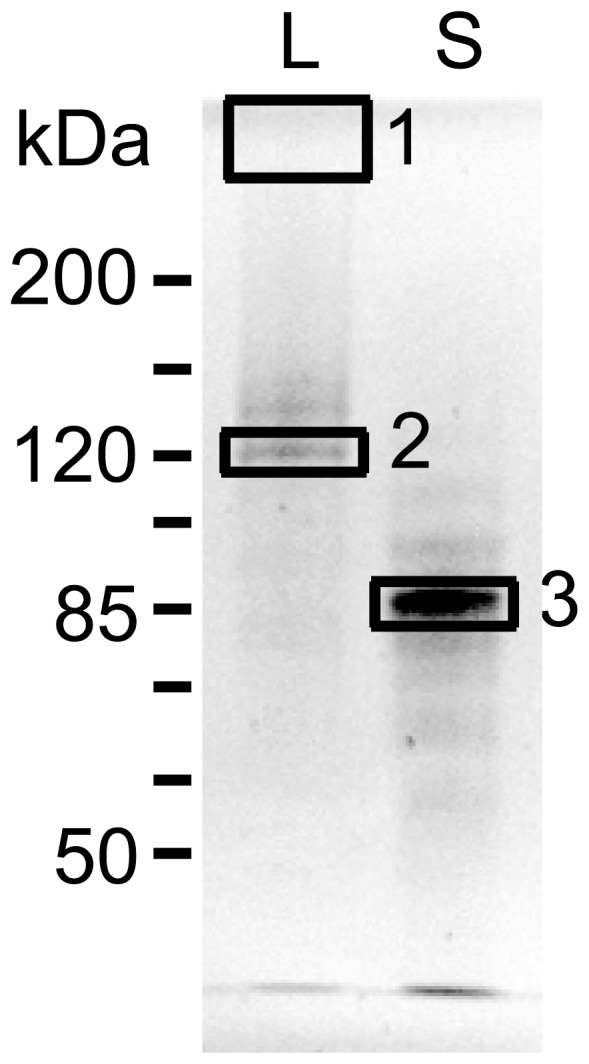
Protein bands corresponding to BGL activities identified as D2 by MS.Concentrated size exclusion chromatography fraction pools were run on a 7% SDS polyacrylamide gel and stained with SYPRO Ruby protein stain overnight, and photographed using Gel Doc system (Bio-Rad). L: higher molecular weight peak, S: lower molecular weight peak. For the actual sample submission, L and S were loaded 2 lanes apart from each other to avoid cross-contamination before cutting out the bands. None of the bands was identified with >95% probability as a known protein in NCBI database using Mascot sequence query at the time of analysis (December 2010). All 3 bands were identified as the D2 protein with 100% probability.